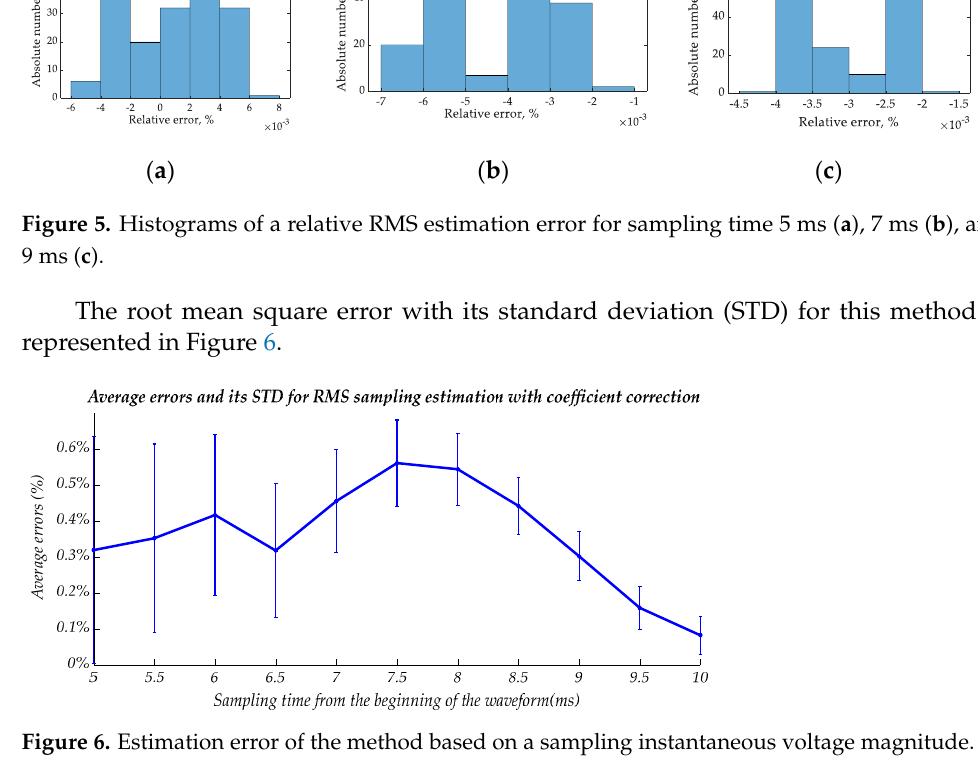
Figure 8. The average relative route-mean-square error for one-two, and three-harmonics represen- tations as per sampling time. As in the previous method, the error decreases with the increase in sampling time and with more significant harmonics signal decomposition. The STD of an error can be even more than its average value and comprises 0.6–1%. This circumstance can be ex- plained by the relatively low value of an average error having scattered statistics. The accuracy of this approach for a one-harmonics representation is close to that of a previous method based on sampling voltage magnitudes. However, it became signifi- cantly more accurate with the use of two- or three-harmonics. The average error in this case for the (6–7 ms) sampling time is less than 0.25–0.35% substantially better than for the method based on voltage sampling in a fraction of the AC period time. 4. Discussion The requirement to keep voltage inside narrow boundaries over time has grown into an actual obligation during the last ten years. The need for fast voltage correction in dis- tribution lines and other important locations in electric grids has become more and more